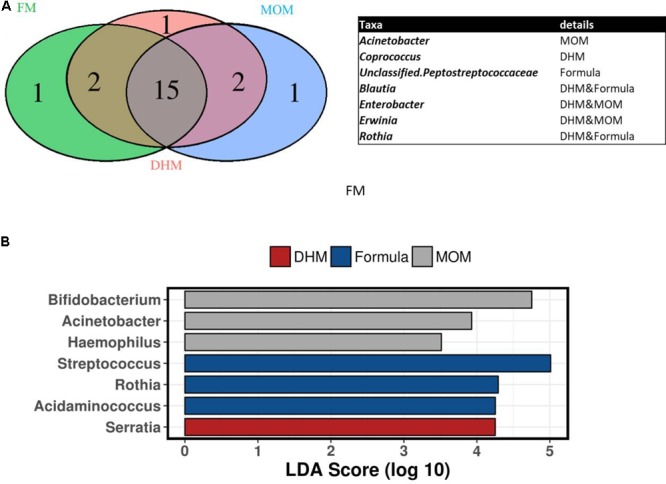
Venn diagram of shared genus between group (A) and linear discriminant analysis LEfSe test at genus level between MOM, DHM, and formula preterm microbiota (B).